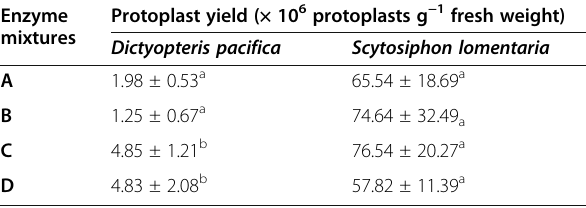
Table 2 Protoplast yield of Dictyopteris pacifica and Scytosiphon lomentaria obtained from different enzyme combinations Enzyme mixtures